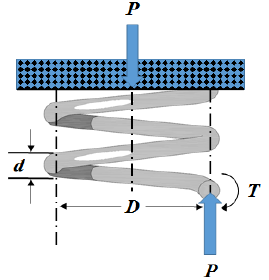
Figure 1. Forces in a compressive spring [3].